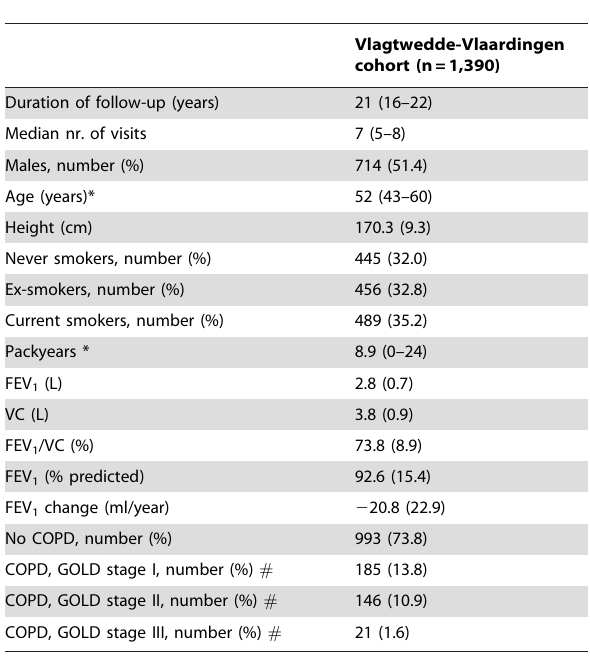
Table 1. Clinical characteristics of the Vlagtwedde- Vlaardingen cohort at the last